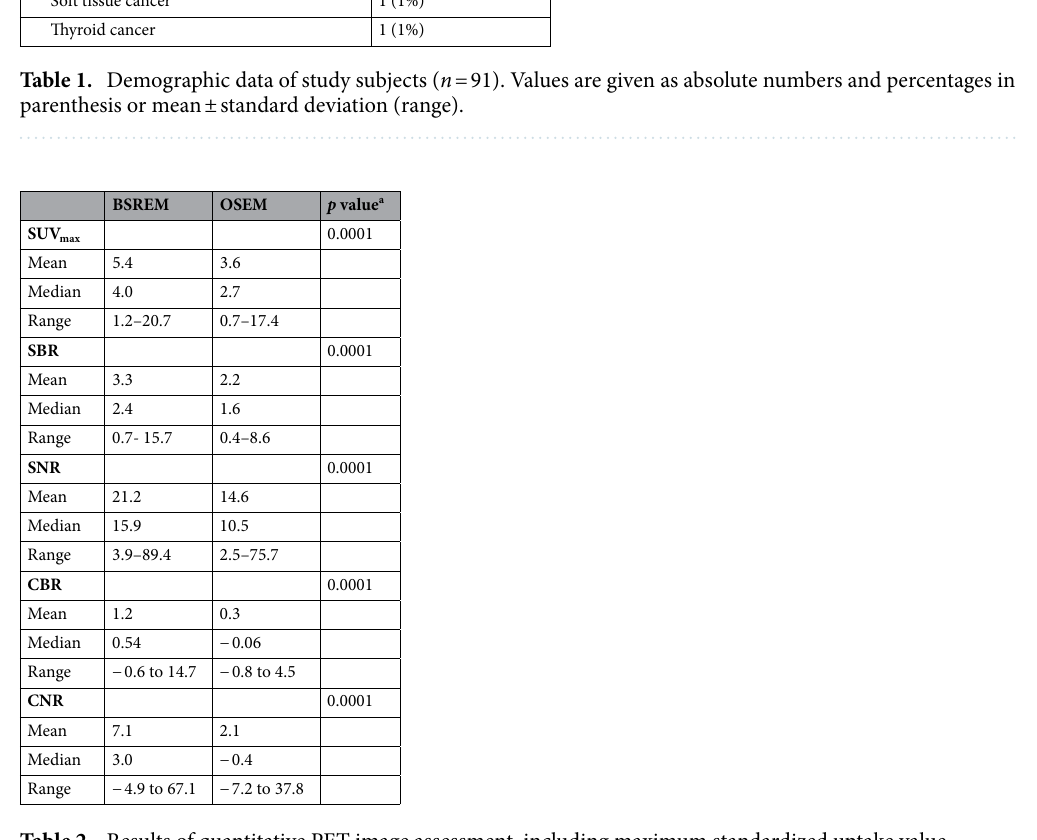
Table 2. Results of quantitative PET image assessment, including maximum standardized uptake value (SUV max ) of the lung nodules ( n = 144), nodule signal-to-background ratio (SBR), nodule signal-to-noise ratio (SNR), contrast-to-background ratio (CBR), and contrast-to-noise ratio (CNR) in block sequential regularized expectation maximization (BSREM) compared to ordered subset expectation maximization (OSEM) reconstructions as reference. a Statistical analysis was performed with Wilcoxon matched pairs signed-rank test, p values < 0.05 were considered to be